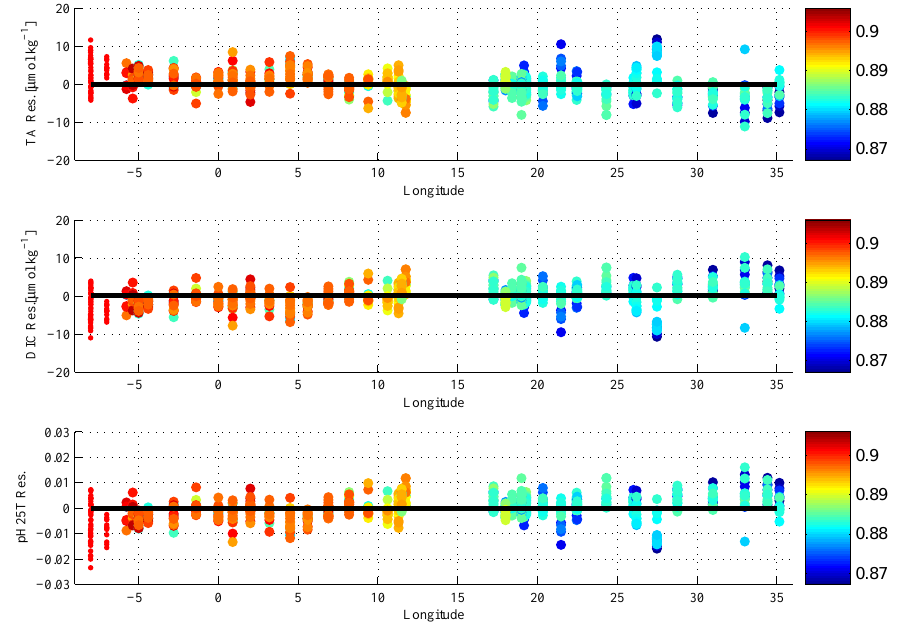
Fig. 3. Same as in Fig. 2 but plotted vs. longitude. The colour code corresponds to the DIC/TA ratio. Two stations to the west of the Strait of Gibraltar were coded as red because DIC/TA ratio > 0.94.